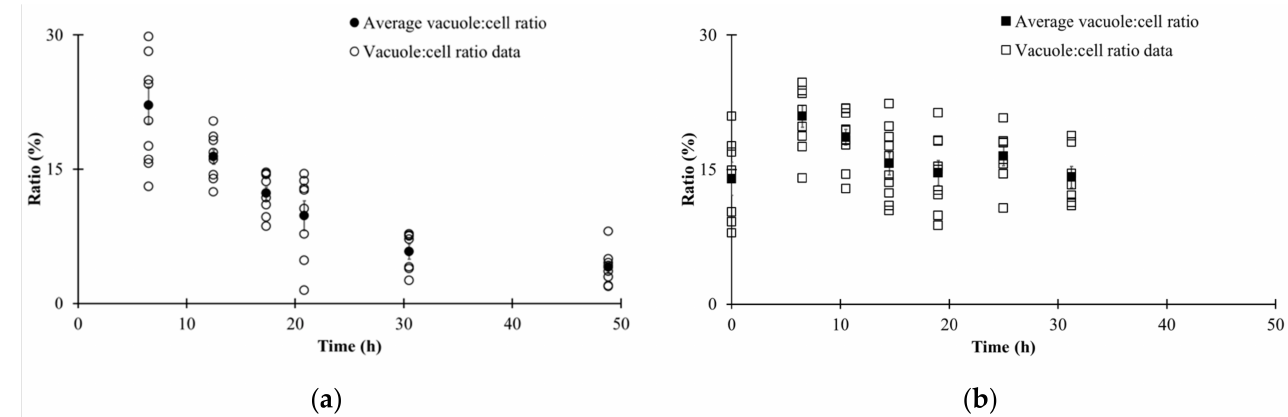
Figure 8. Vacuole and yeast CSA ratio with respect time at 30 ◦ C ( a ) and 35 ◦ C ( b ). Ratio data are represented as follows: data at 30 ◦ C (empty circles) and 35 ◦ C (empty squares); average data at 30 ◦ C (filled circles) and 35 ◦ C (filled squares). Fermentations and automated image analysis were performed in duplicate. The error bars represent the standard error of the data (used to represent the high confidence in the mean associated with a large number of